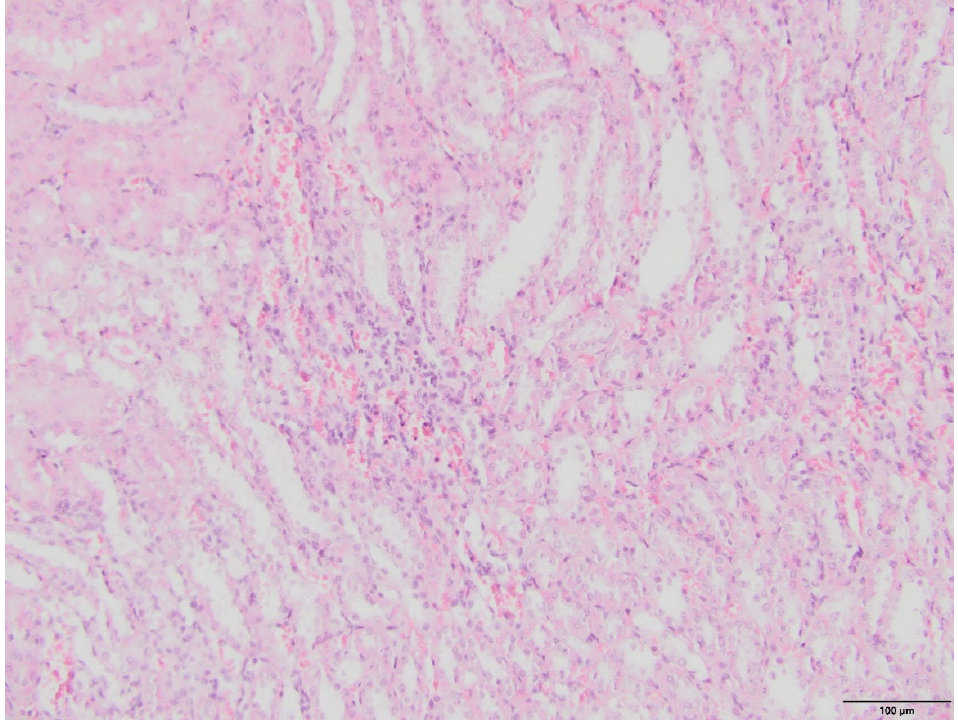
Figure 5. Pathological lesions in kidneys of rats on 10% fructose diet (F10). Mild tubule-interstitial mononuclear cell infiltration. (HE, magnification 20×).